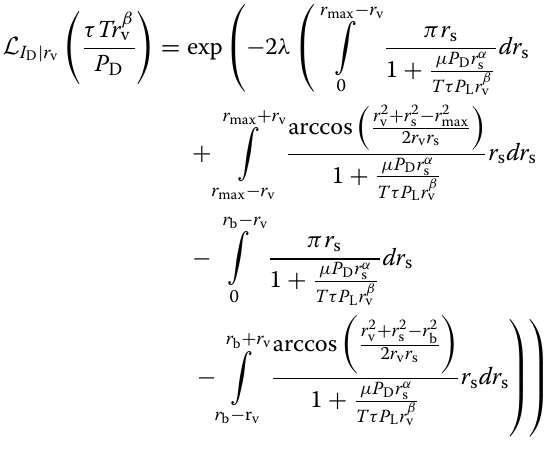
exponential distribution of h : h ∼ exp (μ) , and that if x is exponentially distributed random variable with param- , and (c) follows the eter θ then E x [ exp ( − ax ) ] = 1 1 + ( a /θ) probability generating functional (PGFL) of the PPP. The integration at (c) is done over the unicast area, i.e., over the whole service area O , excluding the broadcast area, or the gap G . term1 corresponds to interference hypothetically produced by BSs distributed over the whole service